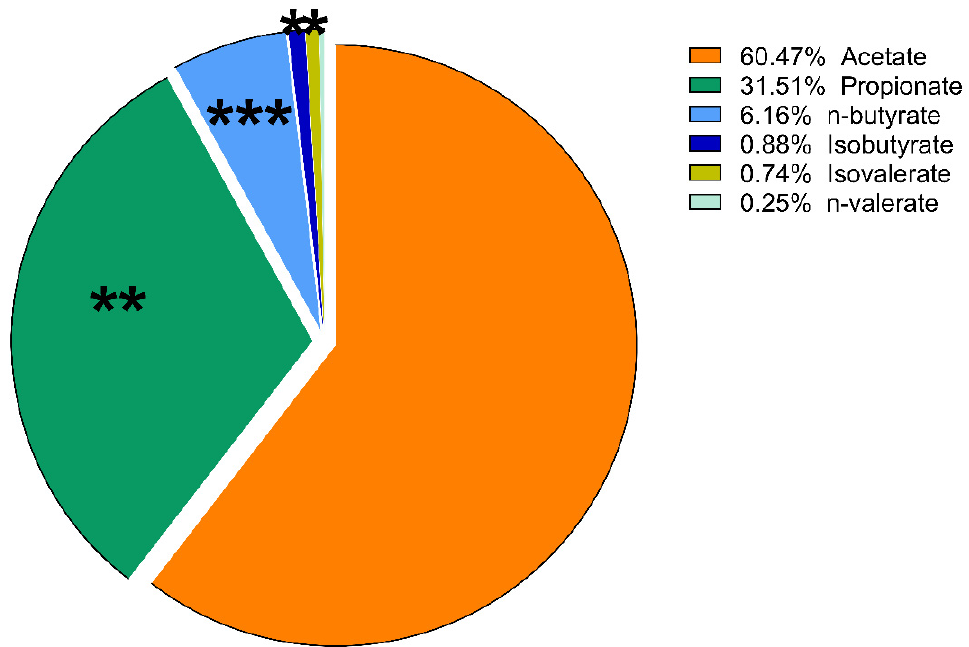
Figure 8. Volatile fatty acid profile of fecal samples of the lactulose group on day 15 of the experiment measured by GC-MS method. Data are expressed as mol%. * p < 0.05, ** p < 0.01, *** p < 0.01.